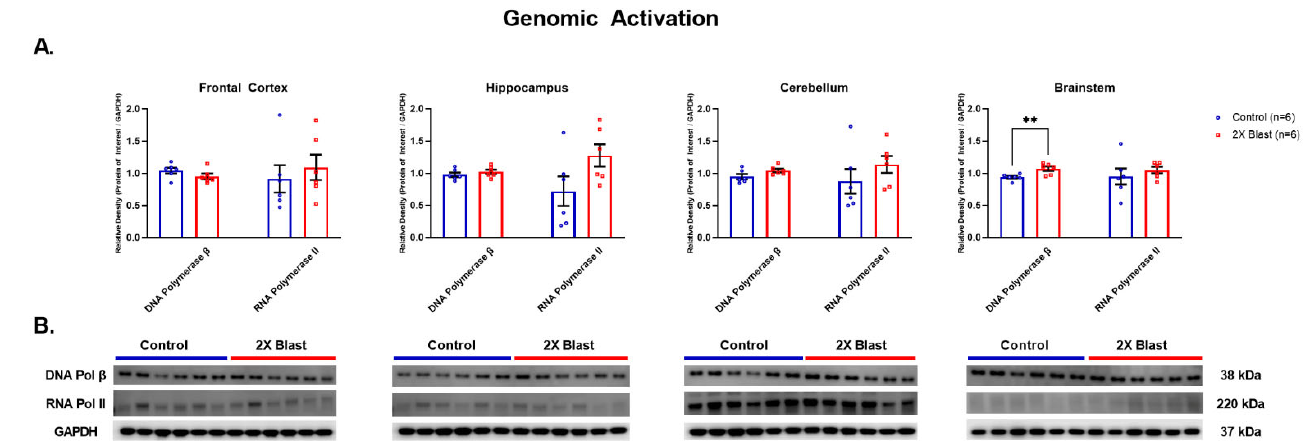
Figure 6. Genomic activation/repair related protein expression changes. ( A ) Densitometric ratio of the levels of DNA Polymerase β and RNA Polymerase II with respect to GAPDH as measured in the FCtx, H, CRB and BS 15-days following an explosive-driven double blast exposure, n = 6 per group, ** indicates p values < 0.01 as determined by 2-tailed, unpaired t -tests. Error bars represent standard error of the mean (SEM). ( B ) Representative western blots # for each antibody used. All gels were run in triplicate and data represents the average of 3 runs per sample. # For full length blots, see Supplementary Figures S12 and